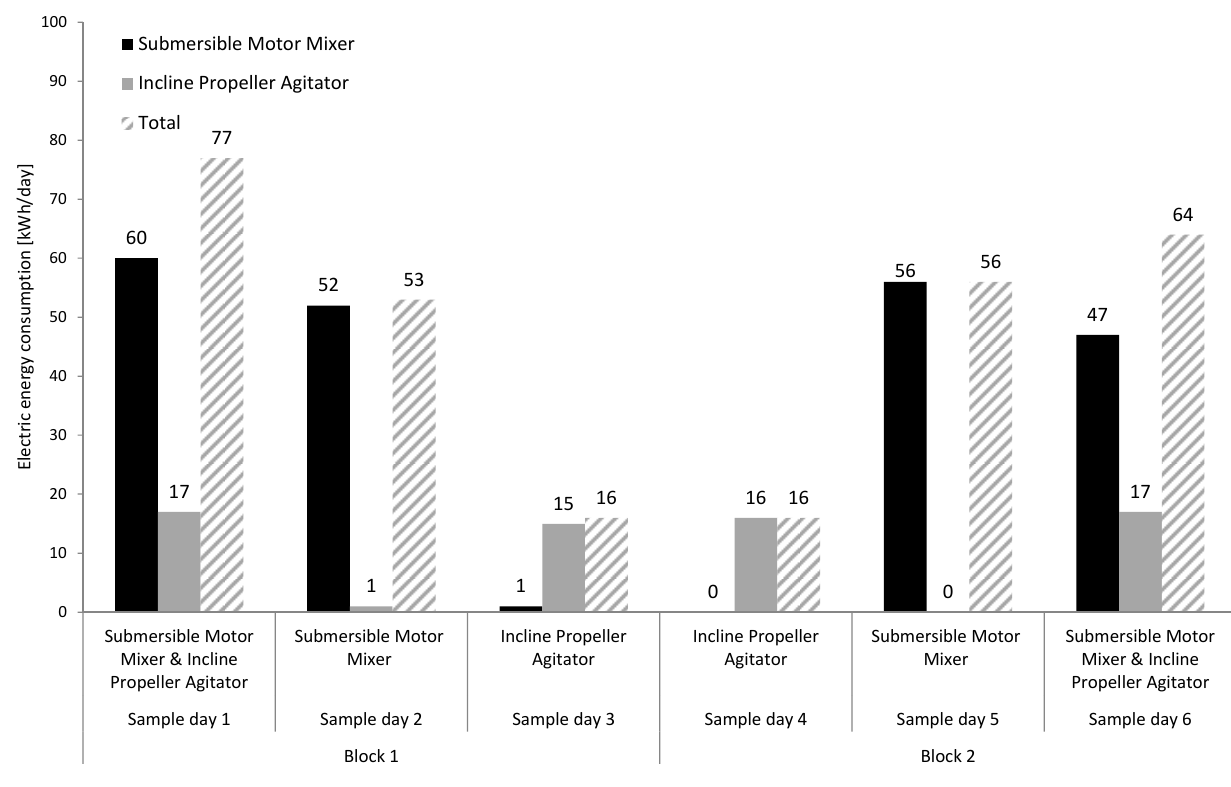
Figure 6. Electric energy consumption of the agitators according to the agitator setup for all sample